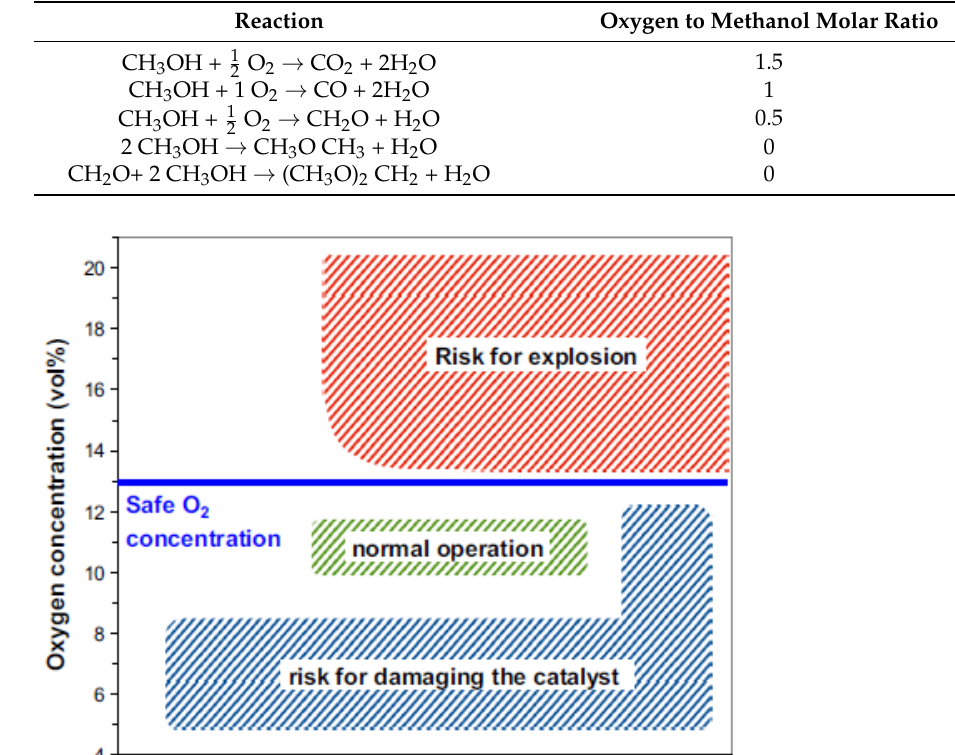
Table 5. Oxygen usage per converted methanol in a MoO 3 / Fe 2 (MoO 4 ) 3 system. Reprint from [99]. Copyright (2021), with permission from Springer Nature.